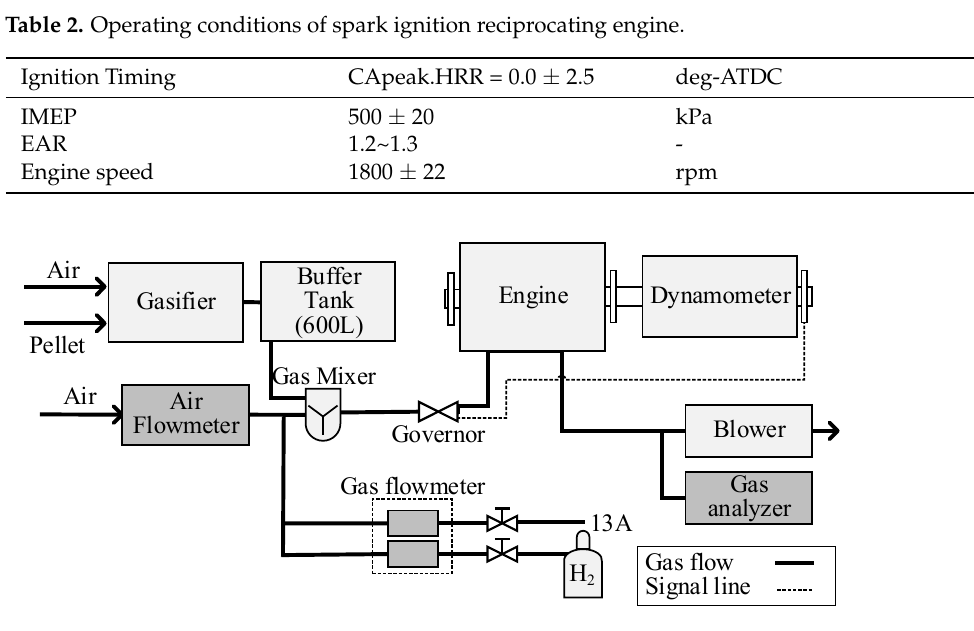
Figure 4. Schematic of reciprocating SI-ICE experimental equipment. Table 3. The mixture in a cylinder with CH 4 addition. Two conditions are used.